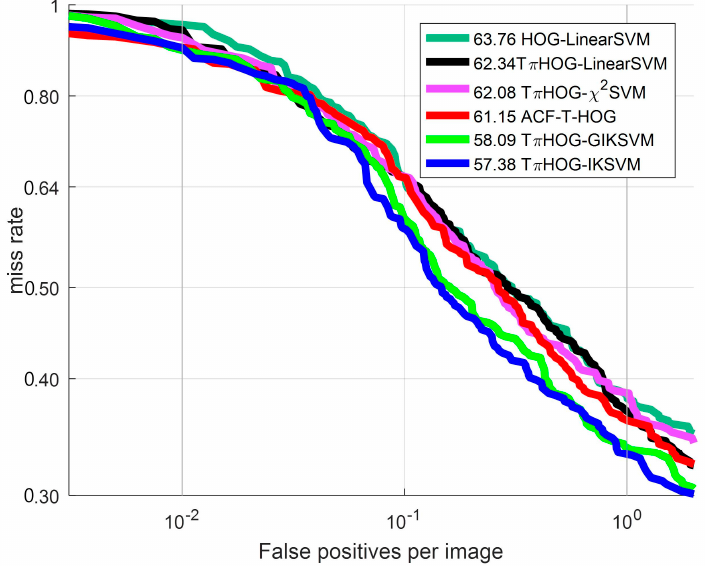
Figure 18. ROC curve: Comparison of additive kernel